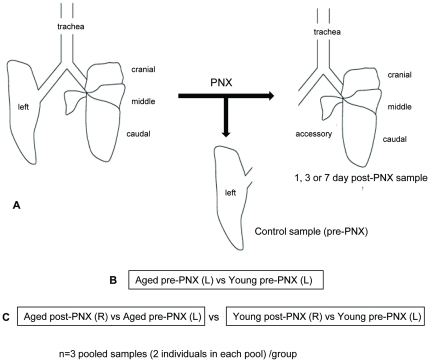
Study design comparing transcriptomic patterns after PNX in 9 vs 3 month mice.
A: Surgeries. Left lung lobe pneumonectomy (PNX) was performed on 18 young (12 week old) and 18 middle-aged (9 month old) female mice. The left lobe of every animal was preserved in RNAlater at the time of surgery. The mice were sacrificed and the remaining right lung lobes were removed at 1, 3 or 7 days post-surgery (n = 6/group). RNA was prepared from the R and L lung lobes of every animal. For each animal, RNA from the left lung lobe was used as the normalizing RNA for microarray analysis. B: Microarray experimental design. At each time point, RNA from two animals was pooled to create one pre-PNX (left lung) sample and one post-PNX (right lung) sample. Therefore, at each time point, 3 pooled samples were created for each group (young pre-PNX; young post-PNX; aged pre-PNX and aged post-PNX). C. Microarray data analysis. We generated two groups of data from the microarray analysis. First, to uncover transcripts that are differentially regulated between young and aged animals, we directly compared the aged pre-PNX samples to the young pre-PNX samples (n = 9 pooled samples/group). Second, to compare the effect of aging on lung regeneration post-PNX, we performed a double comparison by first comparing young post-PNX and aged post-PNX to their own control (pre-PNX) for each pooled sample. (n = 6 data sets/time point), and then using a two-class SAM method to compare these aged vs young data sets to identify preferentially expressed genes in aged vs young post-PNX animals.